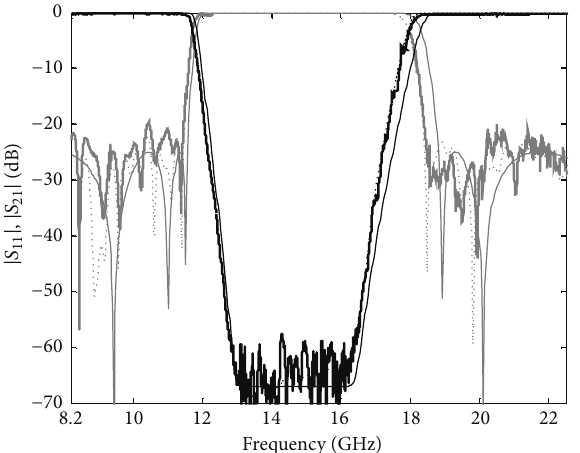
Figure19:Magnitudeofthe 𝑆 11 -parameter(greyline)andofthe 𝑆 21 - parameter (black line) for the final synthesized filter in waveguide technology in Figure 18. The target (thin solid line), simulated (dotted line), and measured (thick solid line) frequency responses are